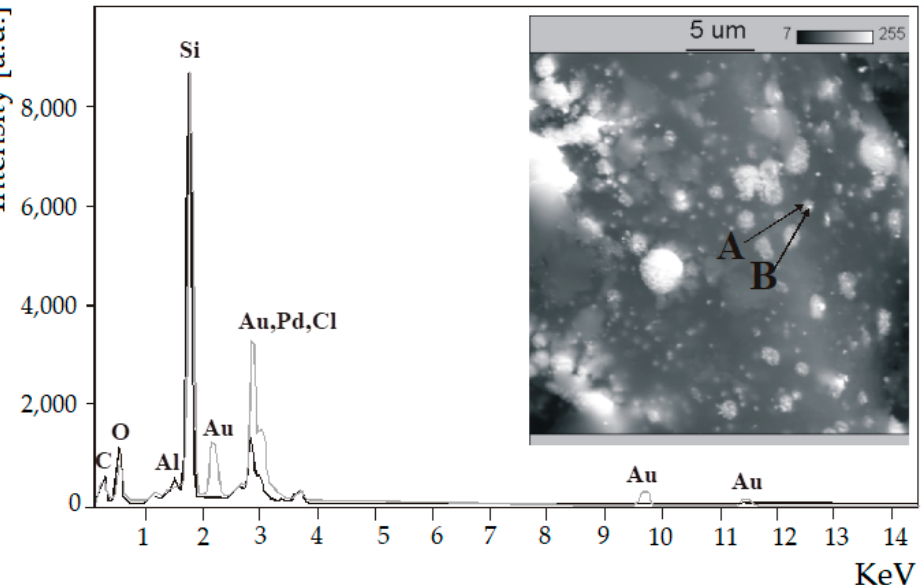
Figure 6. The back-scattered electron (BSE) photomicrograph and the characteristic X-ray spectra of fresh 5%Pd-1%Au/SiO 2 catalyst overlapped at point A—And point B—The catalyst was previously reduced in H 2 at 300 °C for 2 h.